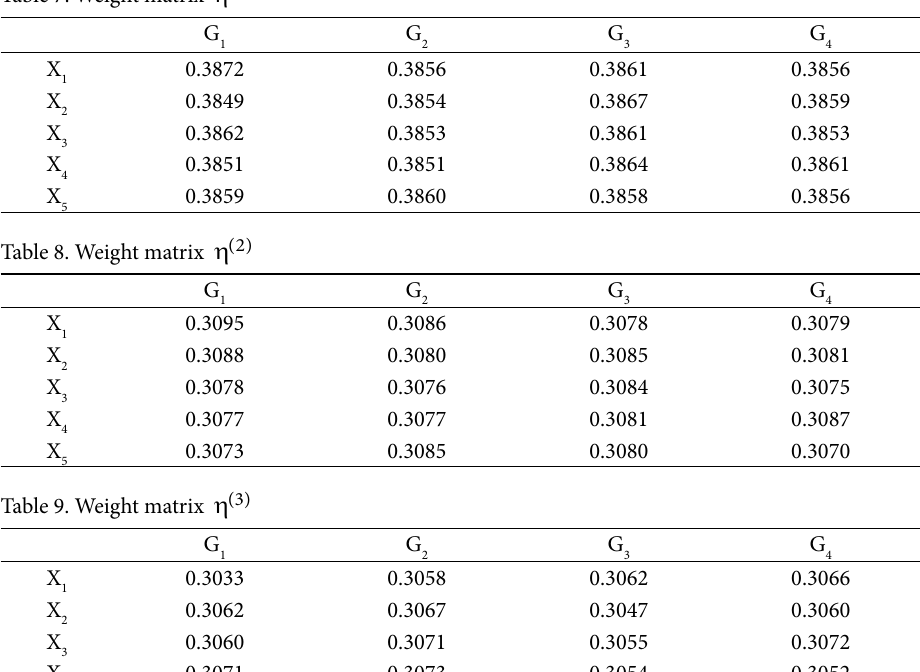
Table 7. Weight matrix (1) η